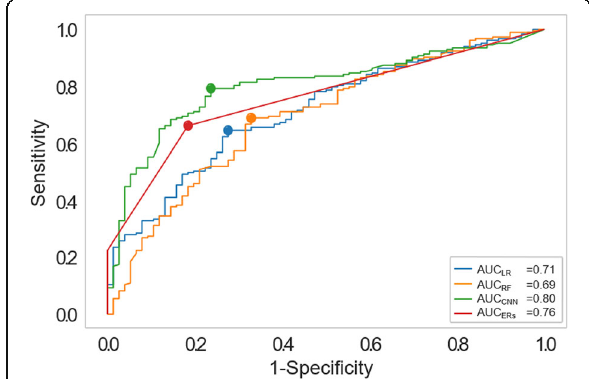
Fig. 5 Receiver operating characteristics curves demonstrating the accuracy of the four predictive models in the binary prediction for 256 patients. LR Linear regression (blue line ), RF Random forest (orange line), CNN Convolution neuronal network (green line), ERs Experienced radiologists (red line).